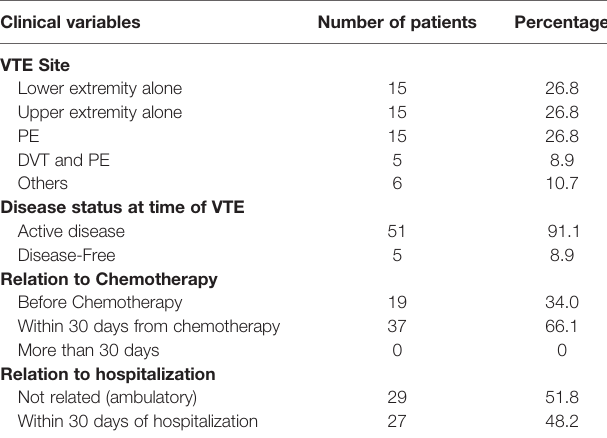
TABLE 2 | Venous thromboembolism